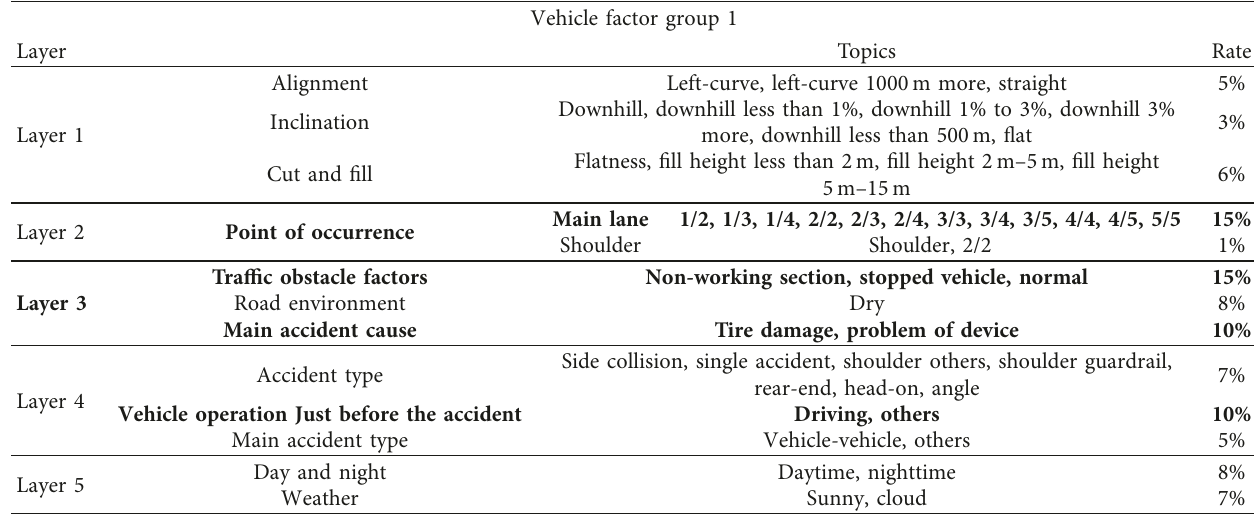
Table 5: Vehicle factor topic modeling group